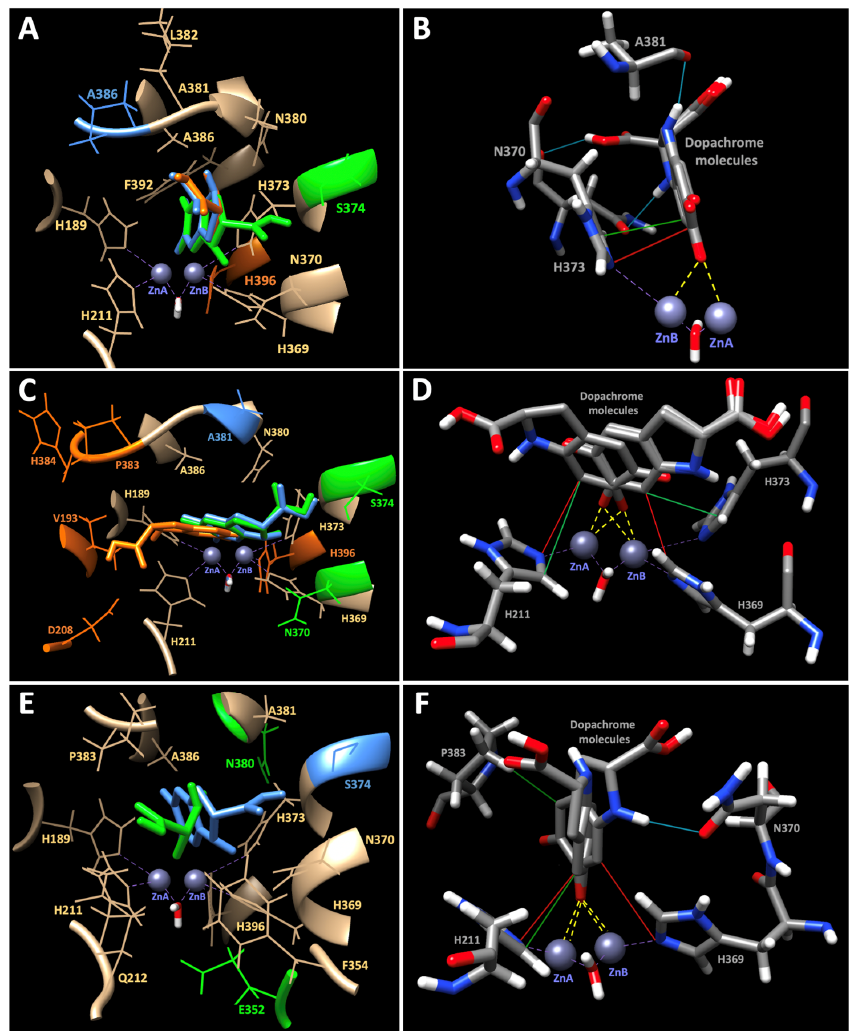
Figure 7. Computational docking of dopachrome molecule to human Tyrp2 and OCA8-related mutants. Dopachrome docked in different poses (show as green, orange, and blue molecules) with Tyrp2 ( A ), C61W ( C ), and G59V ( E ) visualized using UCSF Chimera 1.15.0. All contacting receptor residues, which are common for all poses, are colored tan. Contacting residues specific for the pose are colored with the same color as the molecule. ( B , D , F ) show the dopachrome interactions: hydrogen bonds (blue lines), hydrophobic (green lines), and π–π interactions (red lines). The distances between the docked molecule and Zn atoms, shown as purple spheres, are colored yellow. The dopachrome molecules and contacting residues are colored by elements: carbon with grey, nitrogen with blue, oxygen with red, and hydrogen with white.